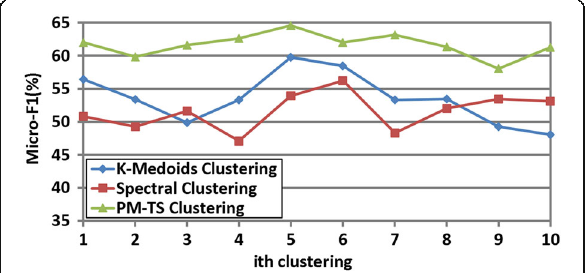
Fig. 9 Whole running time of the three algorithms, run ten times Fig. 11 Micro-F1 of the three algorithms, run ten times